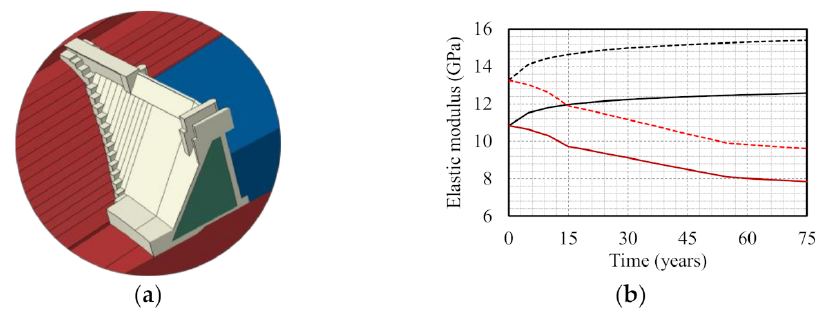
Figure 9. ( a ) Hygro-chemo-mechanically induced surface; ( b ) variation of concrete modulus of elasticity with